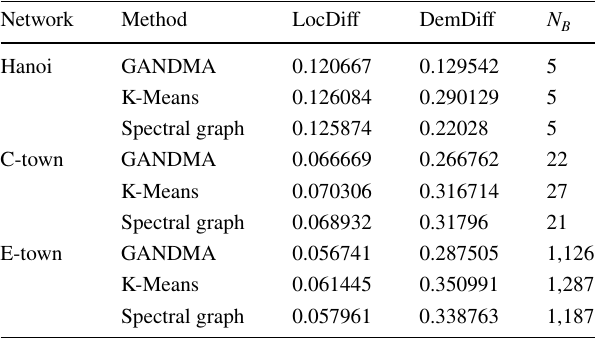
Table 2 Performance of node clustering with different methods in three networks